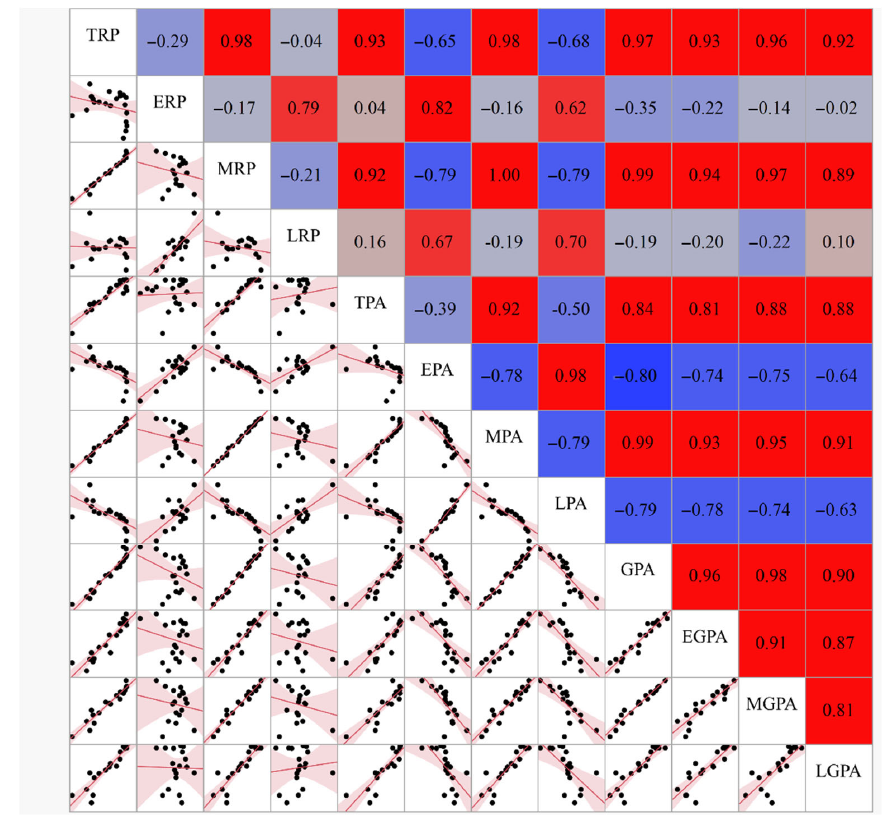
Figure 4. Multicorrelations among the rice production, planting area, and grain yield per unit planting area in early, middle, late, and total rice. The correlations are estimated by the pairwise correlation method.